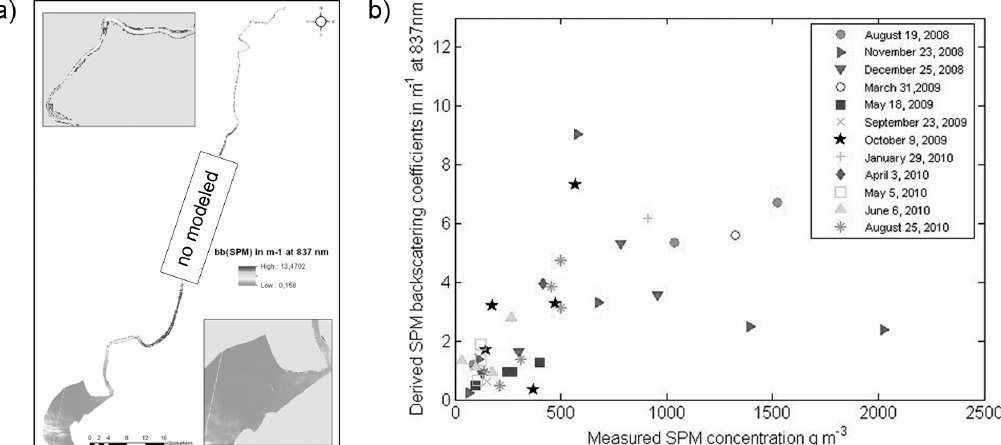
b(SPM) at 837nm on all the days studied.